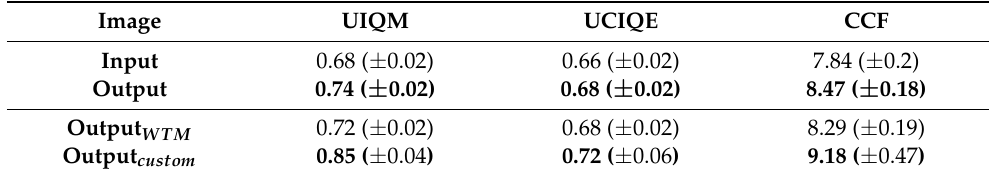
Table 2. Mean image quality metrics for input images and enhanced outputs. Mean output metrics are also displayed according to enhancement type: WTM and custom control-point adjustment.